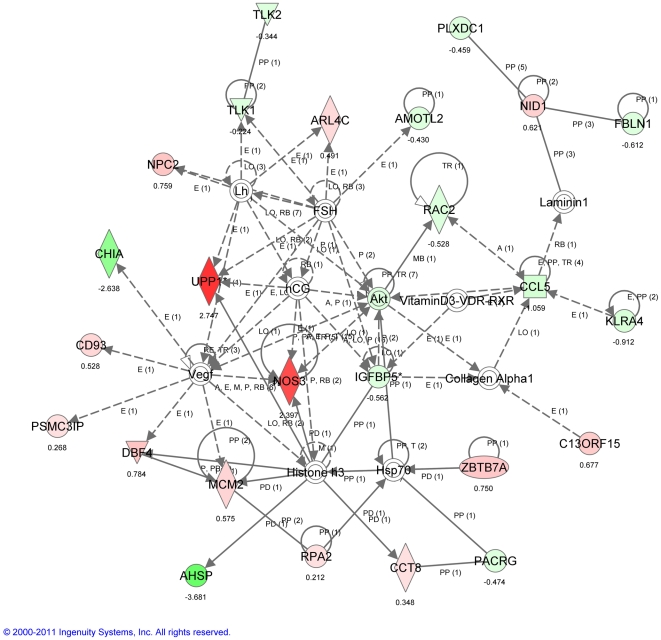
Ingenuity Pathway Analysis (IPA) of transcriptomic patterns 3 days after PNX.Top network illustrates transcripts that are significantly modulated in a whole lung analysis 3 days after PNX in 9 vs. 3 month mice. Green indicates down-regulated transcripts, red indicates up-regulated transcripts. Key: The node shapes denote - enzymes  phosphatases  kinases  peptidases  G-protein coupled receptors  transmembrane receptors  cytokines  growth factors  ion channels  transporter  transcription factor  other .